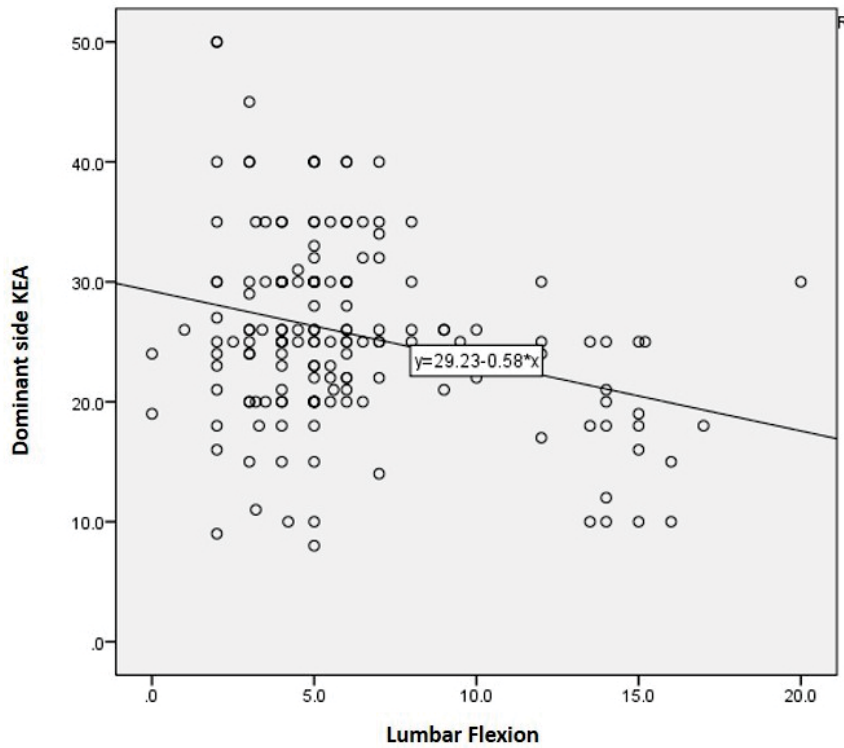
Figure 1: Correlation between hamstring muscle tightness and lumbar motion (LM) during forward